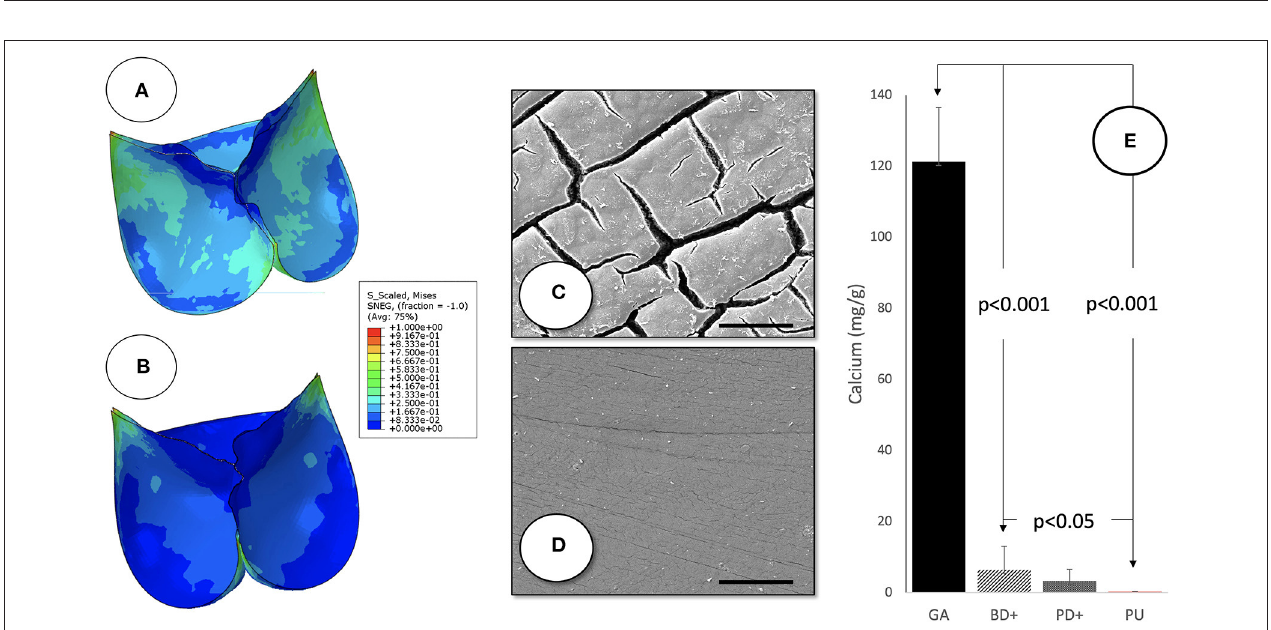
FIGURE 2 | SAT balloon-expandable TAVR valve. The direct bonding to the MP35N-scallop allows an optimal attachment of polymer leaflets to the stent. Both the supra-annular anchorage arms and the spacer arms are structures that are self-elevating on the basis of plastic deformation. The first generation SAT TAVRs show minor differences between the bioprosthetic (A) and the polymer version (B) . The second generation “universal” stent (C) supports both bioprosthetic and polymer leaflets and allows crimp-diameters for trans-femoral access.